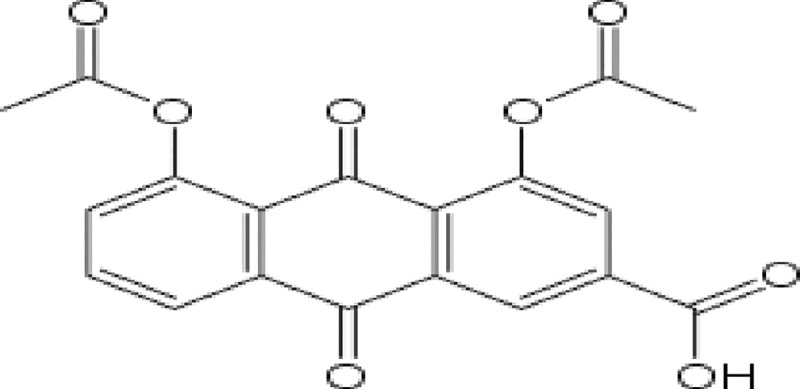
Chemical structure of DCN [1].